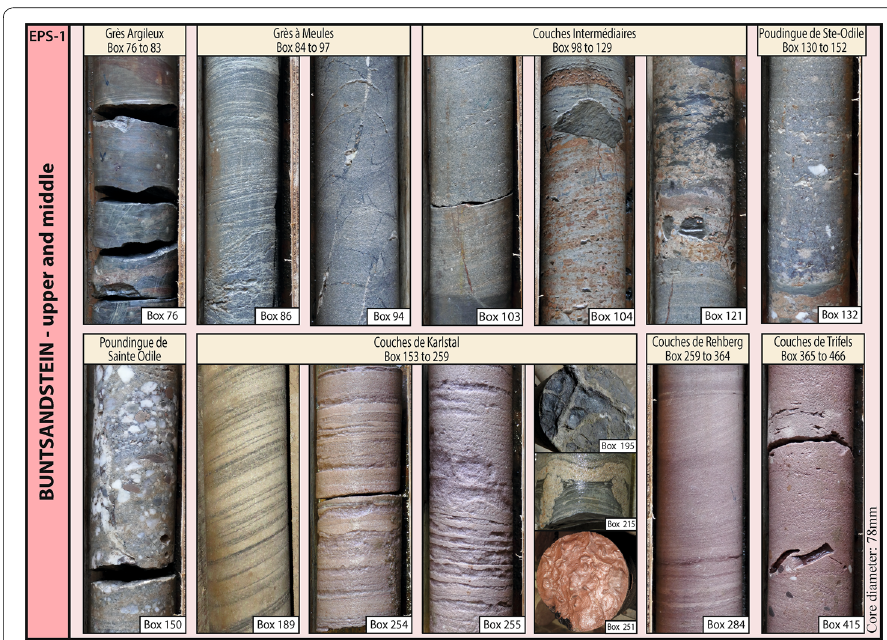
Fig. 6 Photo board of the cores from the upper and middle Buntsandstein, with the Box associated with the cores; this package is correlated to a formation (with the names and boxes concerned). All the cores have a diameter of 78 mm. Box 76, Grès Argileux (upper Grès à Voltzia ) composed of micaceous sandstone and dolomitic sandstone alternating with green to red-colored clays and silty clays. Boxes 86 and 94, Grès à Meules (lower Grès à Voltzia ) composed of massive clayey sandstone banks with thin micaceous surfaces. Are observed in the Box 96 oblique beddings. In the Box 94, occurrence of nearly vertical fractures, filled with white barite. Boxes 103, 104 and 121, Couches Intermédiaires composed of coarse-grained sandstones with oblique beddings (Box 103 and Box 104) alternating with red to purplish clays and silty clays, with numerous rip-up mud clasts and oxidations zones. Boxes 132 and 150, Poudingue de Sainte-Odile composed of coarse-grained sandstone to true conglomerate, with mostly rounded white milky quartz pebbles and very fine-grained red quartzites. Boxes 189, 195, 215, 251, 254 and 255, Couches de Karlstal: this formation presents two distinct facies with planar sandstone beds alternating with horizontally stratified fine silty clay lamina (milli- to centimetric scale) (Box 254 and Box 255) interpreted as typical playa facies with many desiccation cracks (Box 195 and Box 215), wind/wave ripples and small bioturbations (Box 251). The second facies consists of large oblique tabular and trough cross-beds (Box 189), which looks like aeolian dunes shape. Box 284, Couches de Rehberg composed of coarse-grained sandstones with large cross-beddings. Box 415, Couches de Trifels: medium- to coarse-grained sandstones with various mud clasts (sometimes imbricated and formed by desiccation